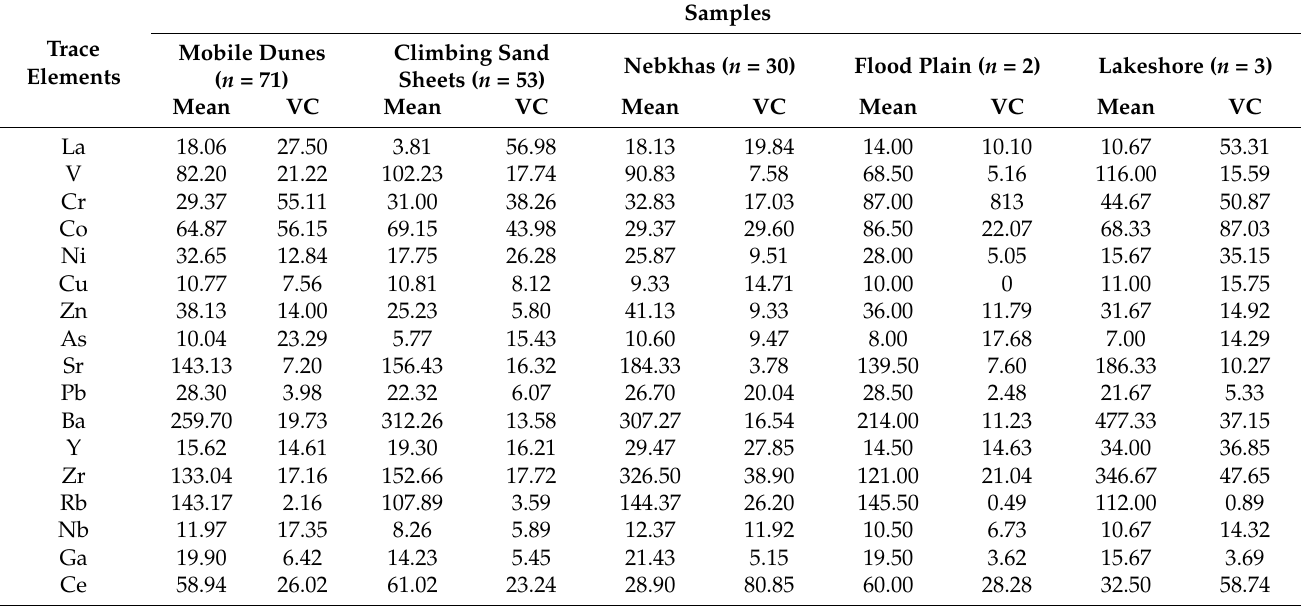
Table 2. Average content of trace elements in modern dunes (ppm).